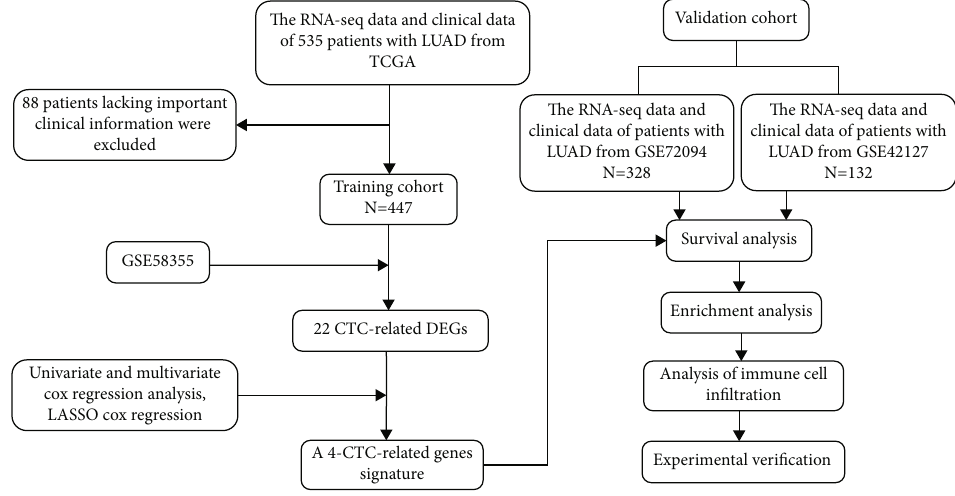
Figure 1: The fl ow chart of the